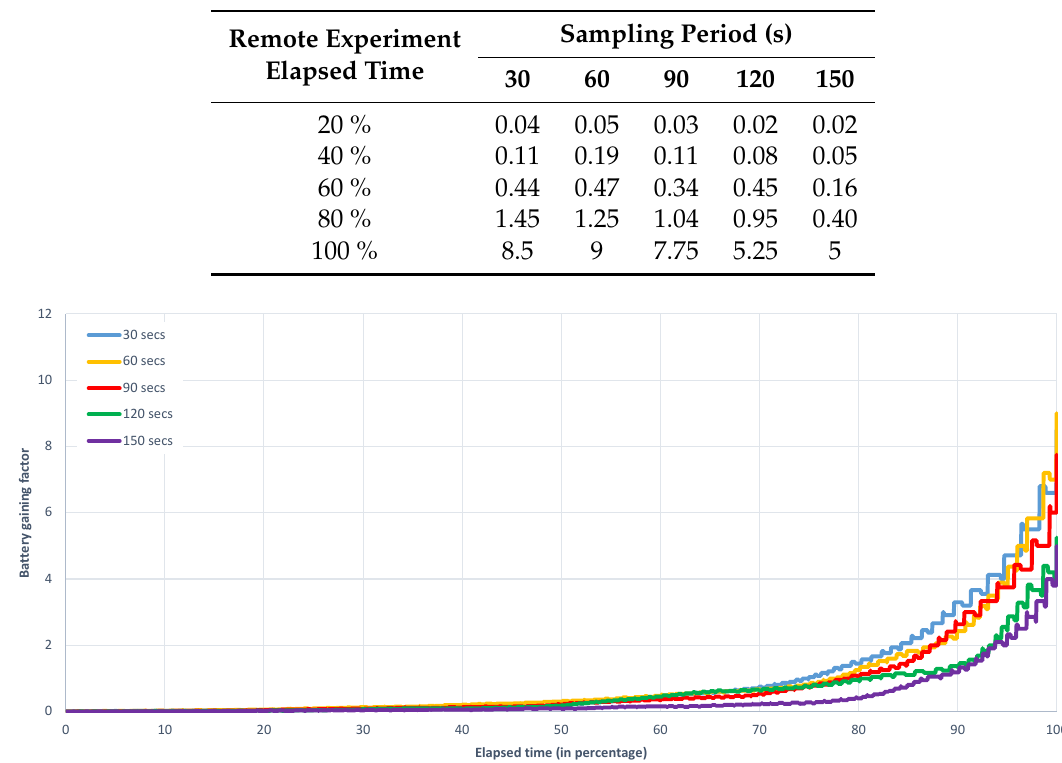
Figure 7. Battery gains obtained by the proposed on-device approach in the different